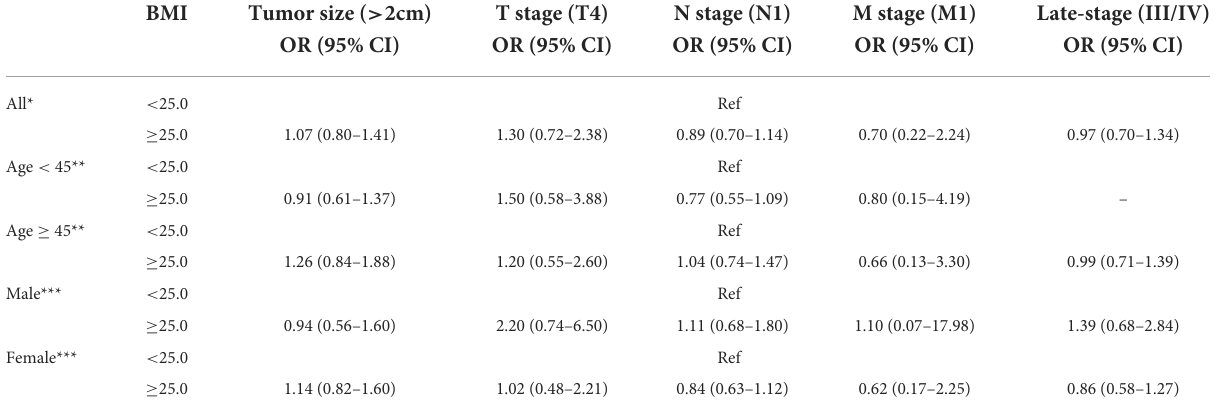
TABLE 3 The association between BMI and aggressive clinicopathological features of DTC